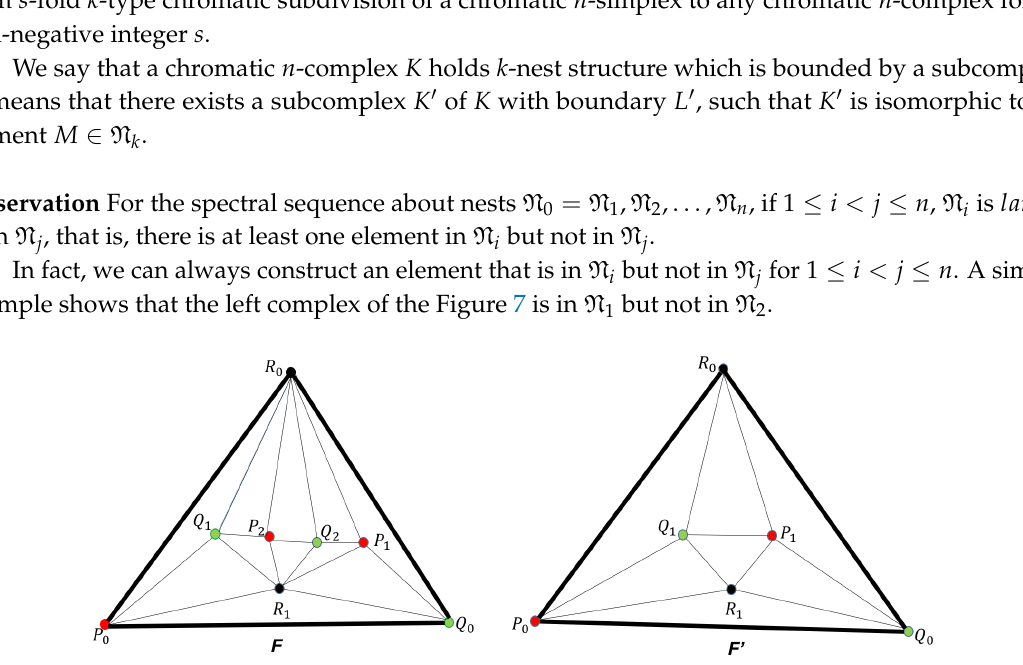
Figure 7. The complex in the left does not hold 2-nest structure, while the complex in the right holds 2-nest structure. But both of them hold 1-nest